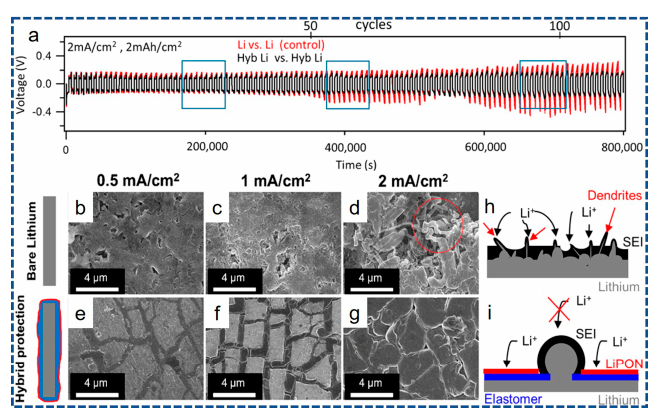
Figure 8. ( a ) Voltage profiles of bare Li/Li (red) and hybrid protected Li/Li at a high current density of 2 mA · cm − 2 and a capacity of 2 mAh · cm − 2 . ( b – d ) SEM images of bare Li metal and ( e – g ) hybrid-protected Li metal cycled for 100 cycles with varied current densities. Mechanistic schematics for ( h ) the bare Li and ( i ) hybrid elastomer/LiPON protection showing Li metal surface layer evolution after 100 cycles at current densities of 2 mA · cm − 2 . ( a – i ) reprinted with permission from Ref. [127] @copyright 2017 American Chemical Society.